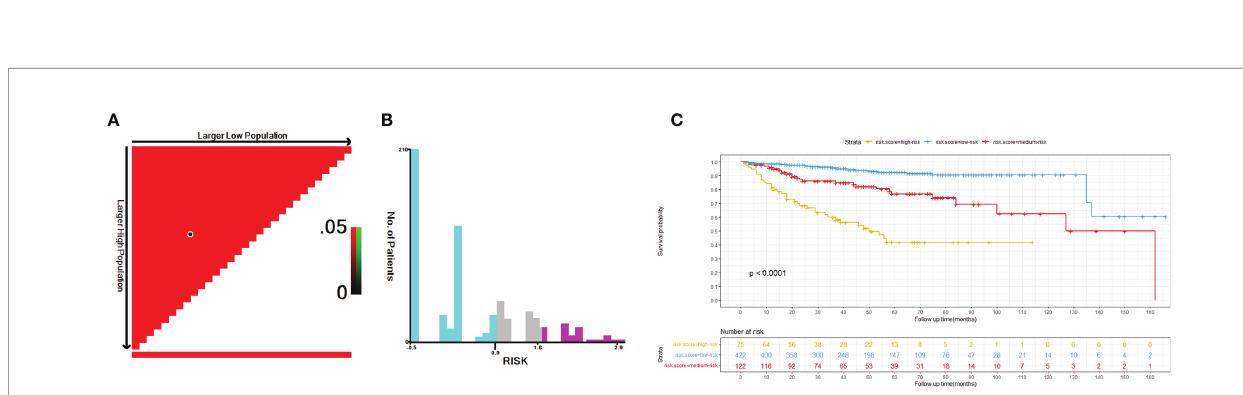
Frontiers in Oncology |